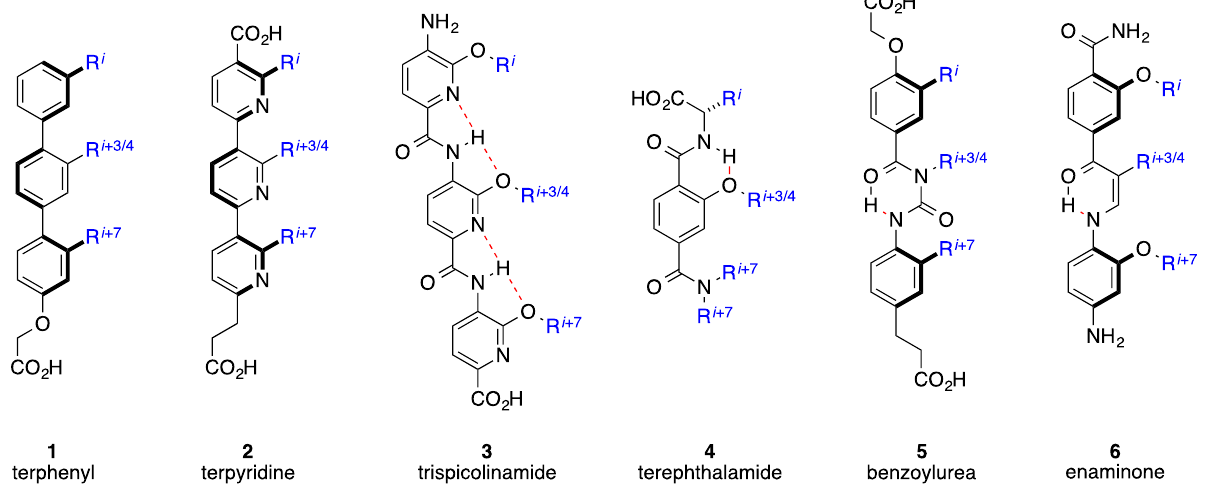
Figure 2. Single-faced, synthetic α-helix mimetics. Dashed lines represent hydrogen bonds.